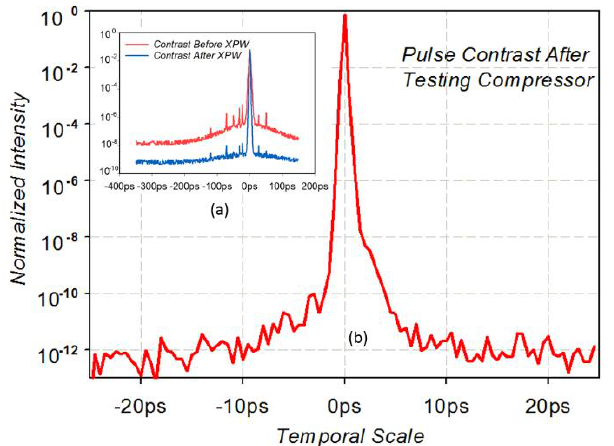
Figure 3. Pulse contrast ratio measured using Sequoia scanning apparatus. ( a ) Contrast ratio measured before (red curve) and after (blue curve) the XPW filter; ( b ) contrast ratio at the end of the entire system.